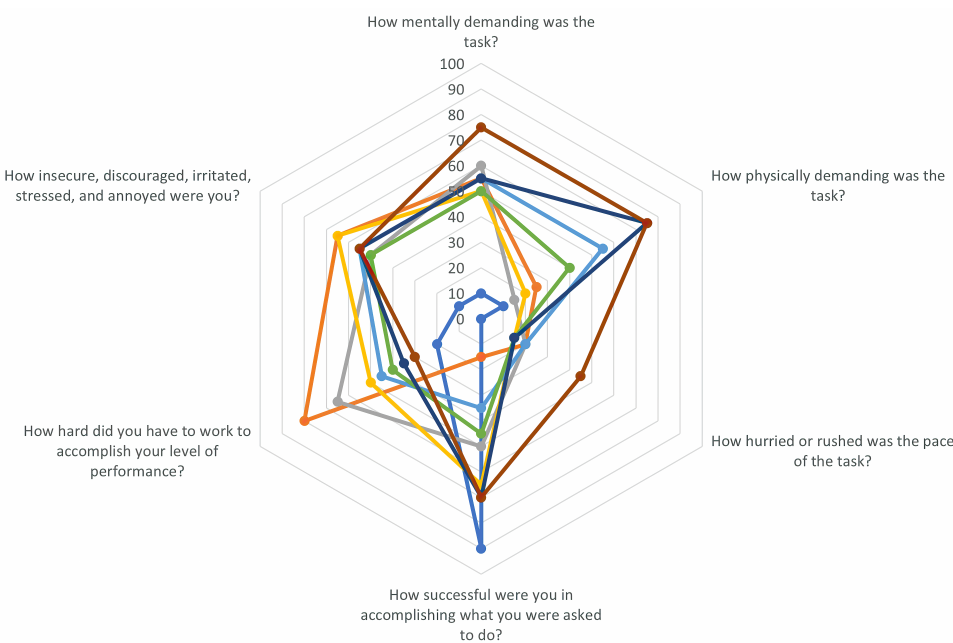
Figure 7. Overlaid participant data collected from TLX questionnaire represented in a radar chart. Fig. 7 displays the collected TLX responses overlaid into a radar chart. The overlaid radar 260